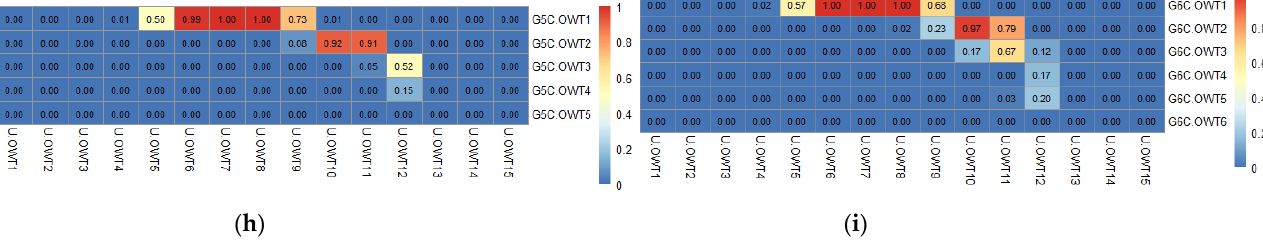
Figure 4. The U-OWT memberships of each water class (represented by mean nR rs ( λ ) vector) corresponding to different AOP-based OWT schemes: ( a ) JL68 (B = 0.1), ( b ) MO09, ( c ) WE16, ( d ) JK17, ( e ) PT19, ( f ) CST, ( g ) MO14, ( h ) G5C, and ( i ) G6C. The relationships of the U-OWT with JL68 (B = 0.01) and with JL68 (B = 0.001) are not shown here, because of their high similarity to the JL68 (B = 0.1).